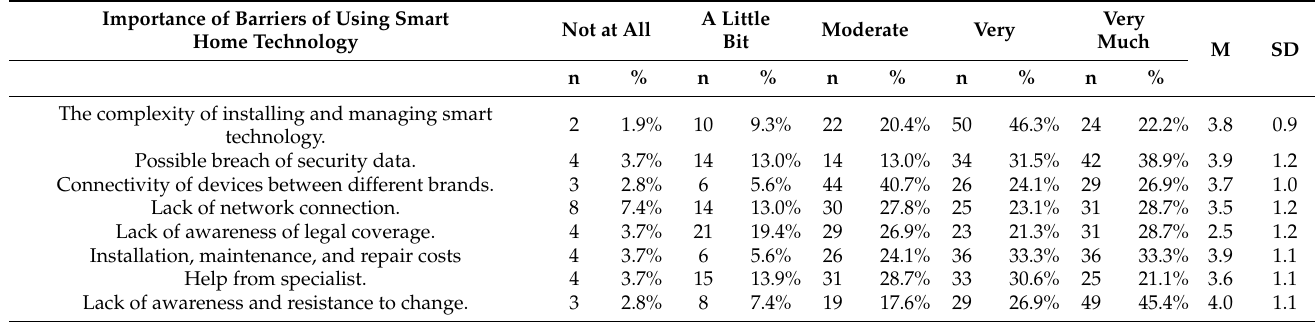
Table A10. Barriers to the use of smart home technology.